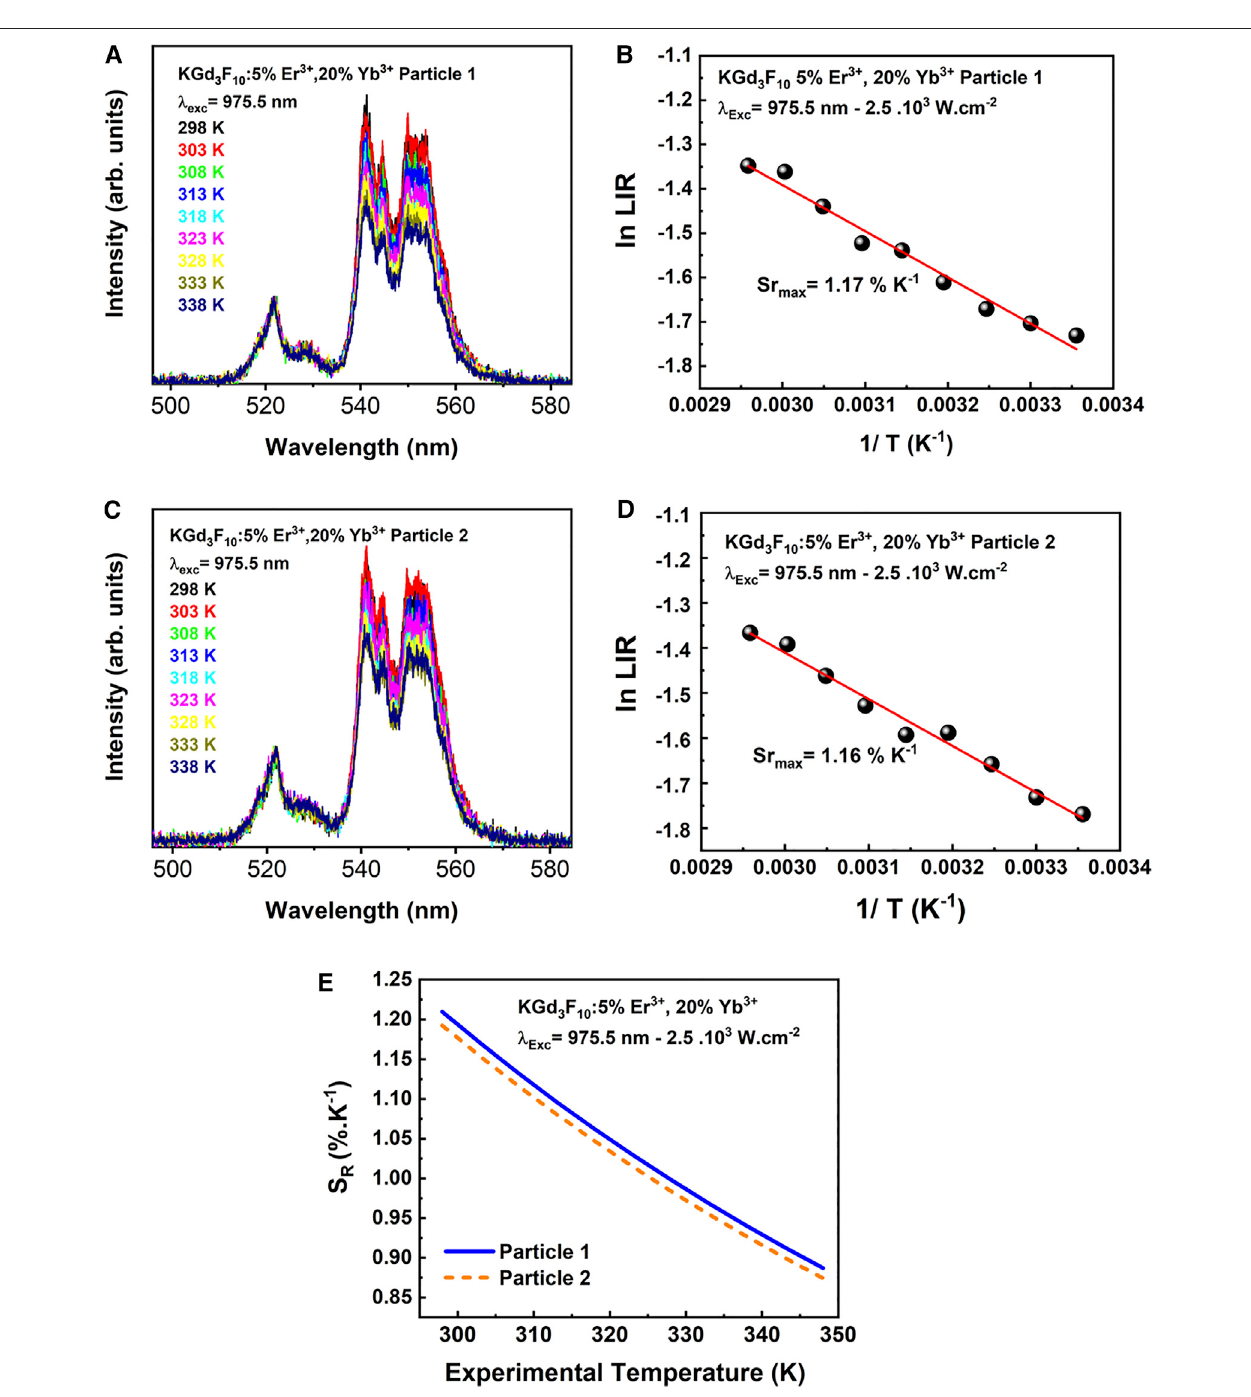
FIGURE 10 | Temperature-dependent behavior of the UC spectra from 298 to 338 K under excitation at 975.5 nm with 2.5 .10 3 W cm − 2 power density (A, C) , relative sensitivities obtained in the green range, under excitation at 975.5 nm (B) and (D) , for the two single Er 3+ , Yb 3+ : KGd 3 F 10 particles. Thermometric parameter S R versus experimental temperature (E) for two single Er 3+ , Yb 3+ : KGd 3 F 10 NPs.